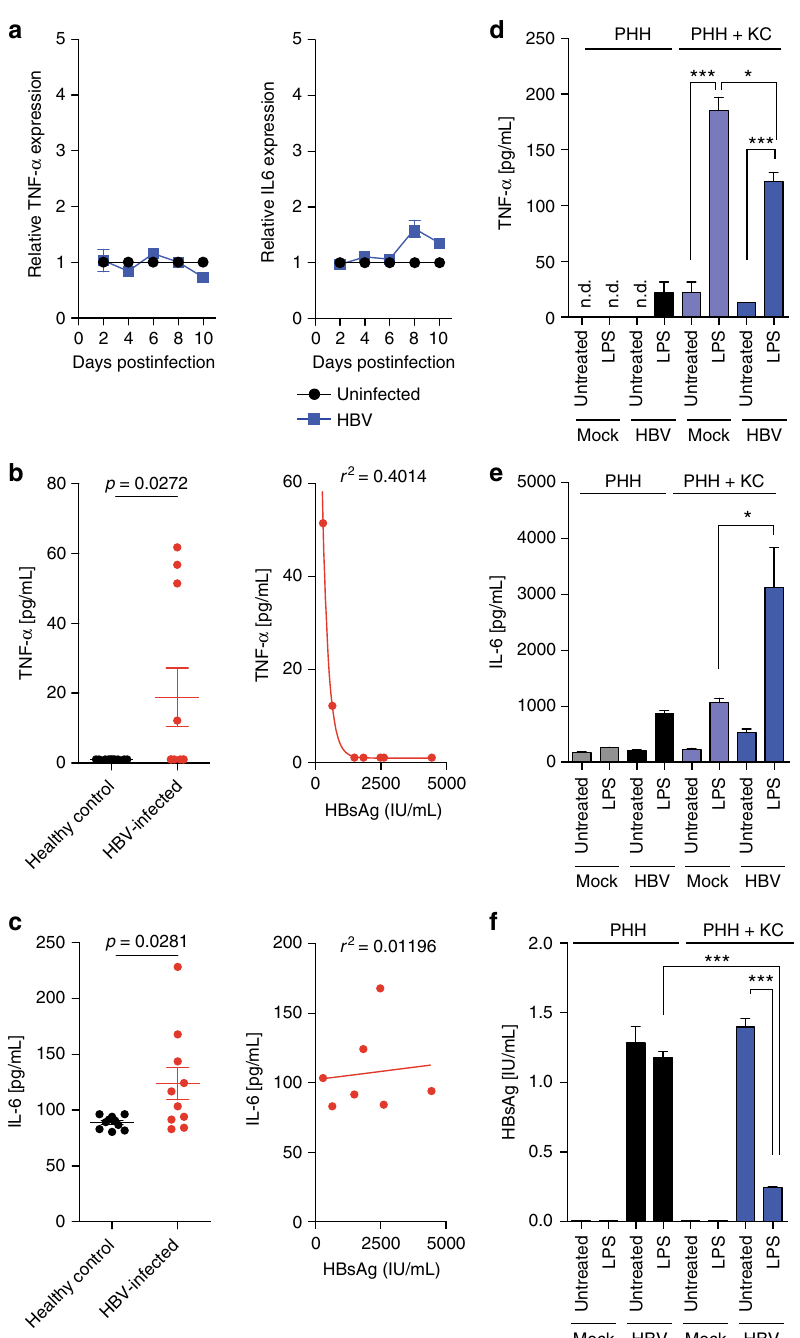
Fig. 7 Exogenous signals are required for Kupffer cell responses to HBV infection. a Longitudinal secretion of TNF- α and IL-6 in 3D PHH cultures infected with patient-derived HBV (100 GE/cell). b , c Serum levels of b TNF- α and c IL-6 as well as correlation with serum HBsAg levels of HBV-infected patients and healthy controls. d – f Secretion of d TNF- α and e IL-6 as well as f HBsAg in 3D PHH cultures and 3D PHH/KC co-cultures infected with patient-derived HBV (100 GE/cell). Cultures were treated with 1 μ g/mL LPS 8 days postinfection, TNF- α and IL-6 levels were quanti fi ed by Luminex 24 h post LPS stimulation, and HBsAg secretion was determined 48 h post LPS stimulation. Data shown are mean ± SD of three independent experiments (* p < 0.05, *** p < 0.001; two-way ANOVA with Bonferroni